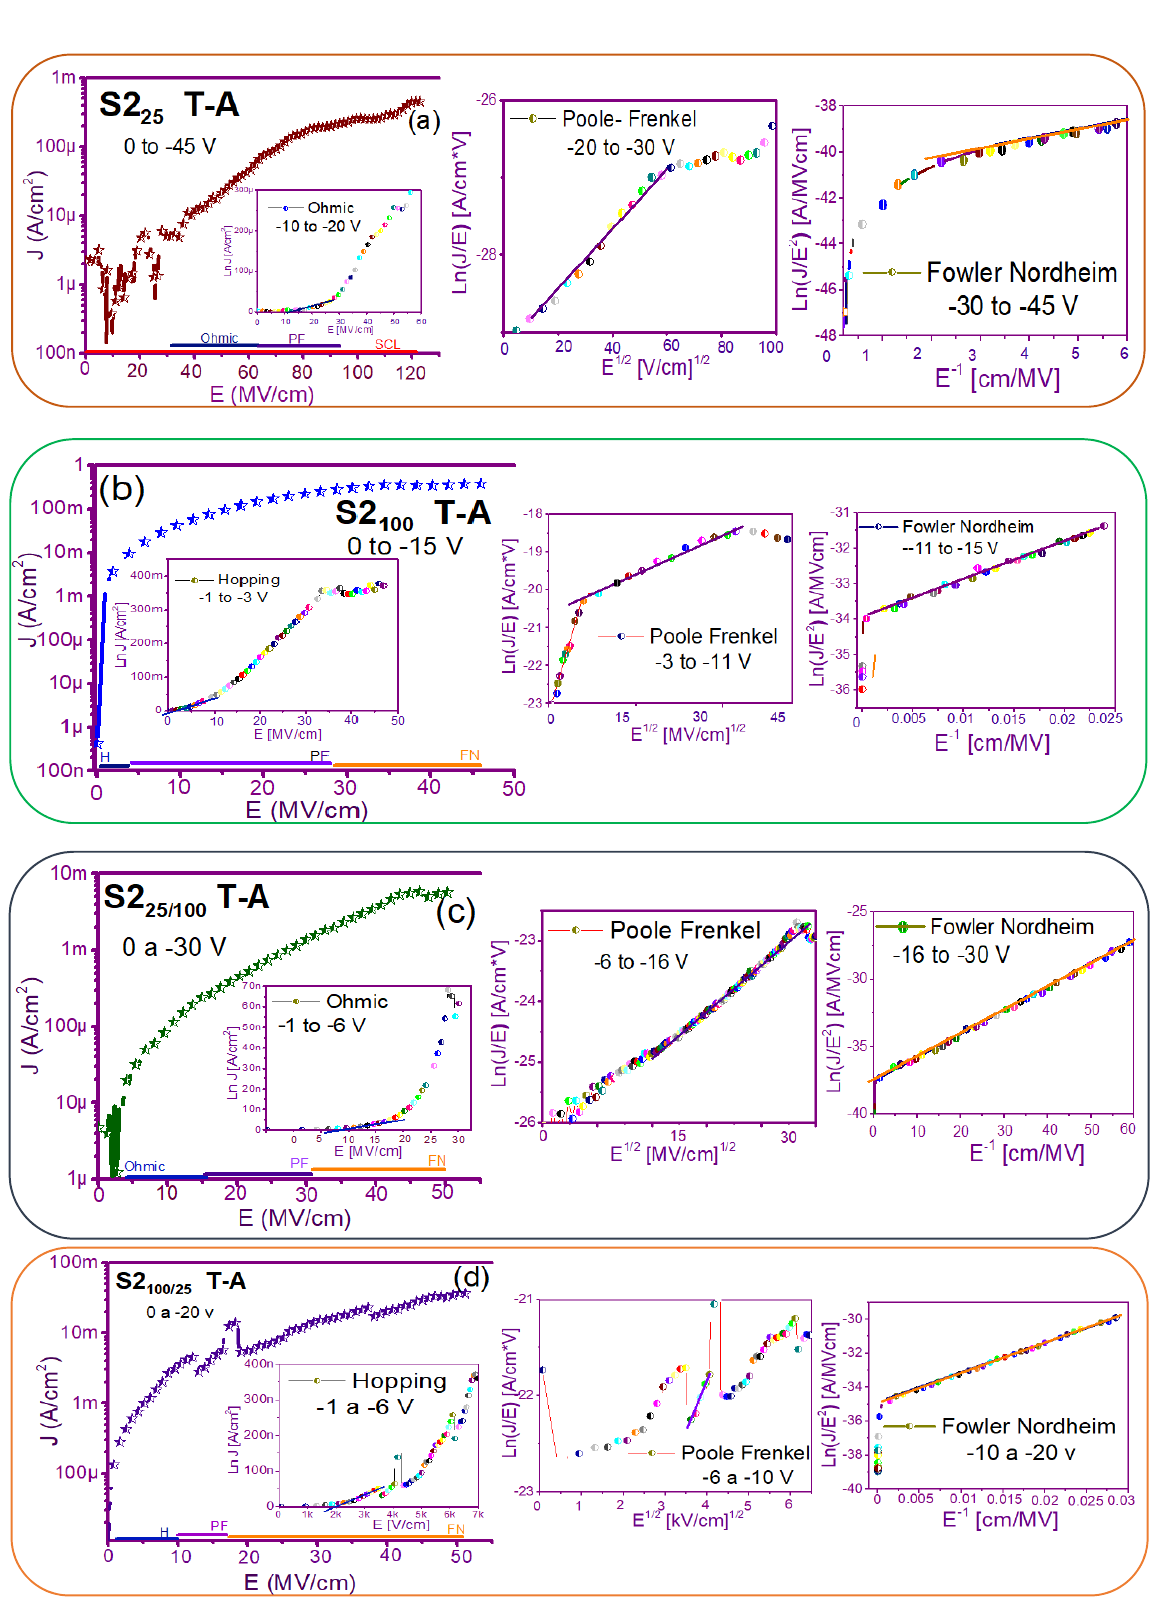
Figure 8. J-E curves of the different conduction mechanisms ( a ) S2 25 T-A, ( b ) S2 100 T-A, ( c ) S2 25/100 T-A, ( d ) S2 100/25 T-A. As can be seen, there were several conduction mechanisms in the J-E curve of these structures. That is, for low electric fields ( ≤ 1.6 MV/cm), the carriers reached enough energy to overcome the energy barrier at the Si/SRO interface and dominate the Ohmic conduc- tion mechanism, as is shown in the inserts of Figures 7a and 8a,c. Another predominant conduction mechanism was observed in intermediate conduction regime at low electric fields, in both S-L and D-L SRO films, this is called Hopping conduction (H) [34,47–50], as seen in J-E curves in Figures 7b–d and 8b,d, and it was originated by the trapped electrons jumping from one trap to another within the film SRO. Also, the energy of the trapped electrons may be less than the maximum energy of the potential barrier between the two traps; in this case, the trapped electrons may have continued traveling using the tunneling mechanism. On the other hand, the Poole–Frenkel conduction mechanism was reported in SRO films where some electrons were found in traps and by thermal excitation were released so they could be conducted within the conduction band of the SRO films by applying an electric field through the dielectric SRO, then electrons crossed the Coulomb barrier which was reduced by the electric field and then increasing the probability of that an electron would be thermally excited from the trap becoming free to travel in the conduction band of the dielectric. The Poole–Frenkel (P-F) conduction mechanism depended strongly on the electric field, and it was independent of temperature, and the electric field was limited to low values (2 MV/cm) [34,47]; one can see this conduction mechanism in the inserts of Figures 7a and 8a–d. Additionally, the tunneling Fowler–Nordheim conduction mechanism has been pro- posed for the SRO films containing Si-ncs or silicon islands where electrons can tunnel by the effect of the electric field existing between the Si-ncs or silicon islands and generated by the potential barrier with a triangular shape (or another one) [34,51]. This generally occurs in not very thin dielectric films (>3.5 nm) and at high electric fields (>2 MV/cm),